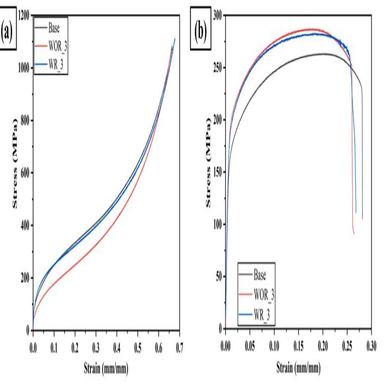
Stress-strain curves of (a) compression test, and (b) tensile tests for all material conditions.